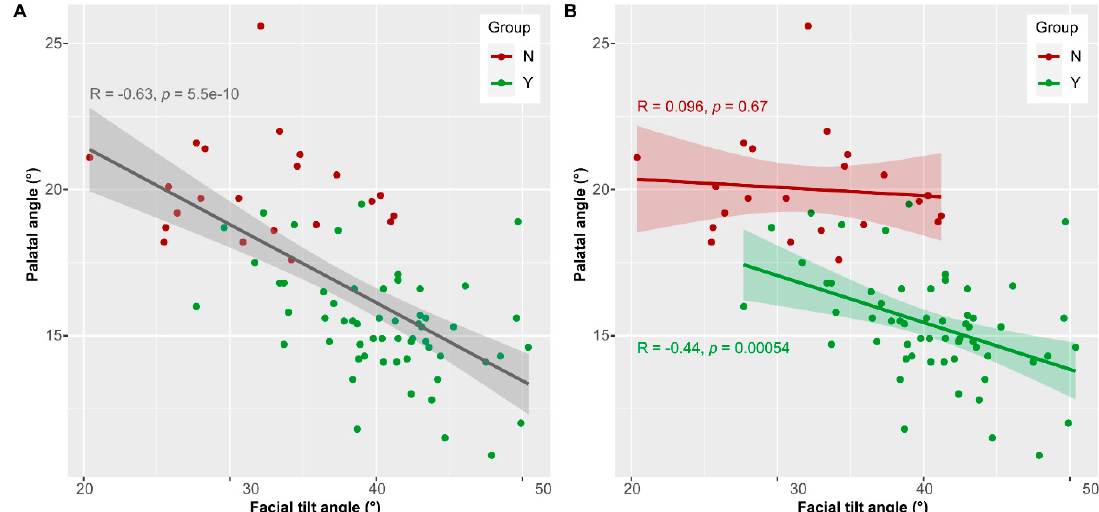
Figure 5. Relation between facial tilt angle and palatal angle. ( A ) Linear regression considering all data. ( B ) Linear regression considering the two groups separately.